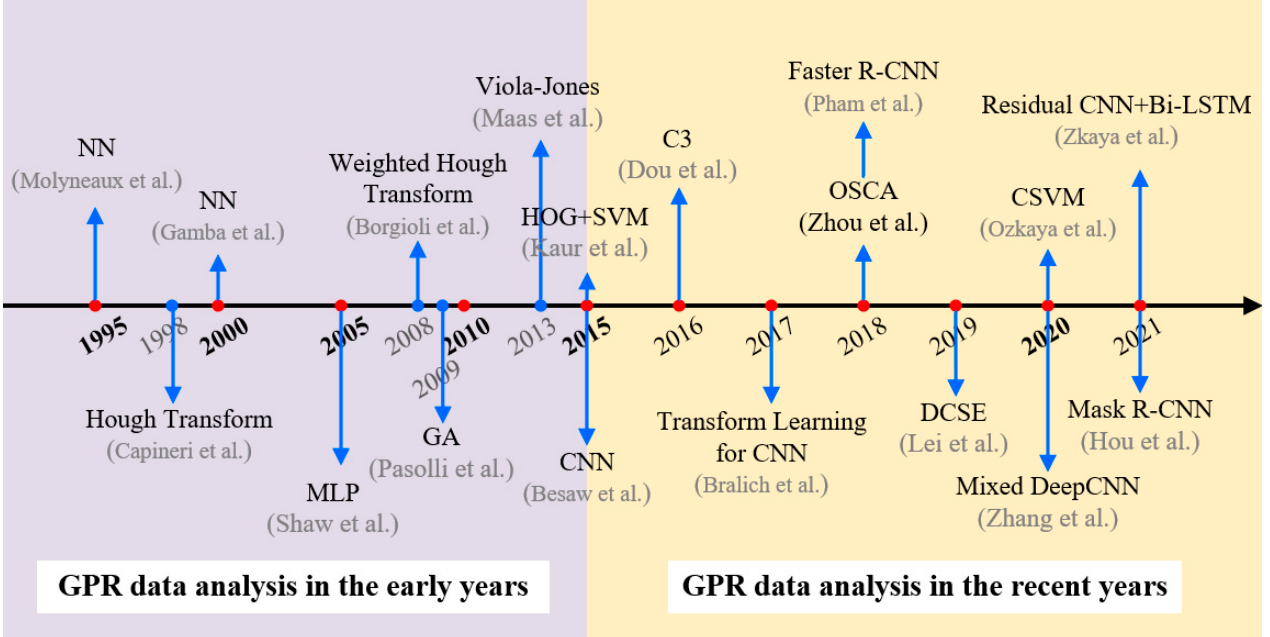
Figure 1. The evolution of GPR data analysis methods over the past decades [5–22].